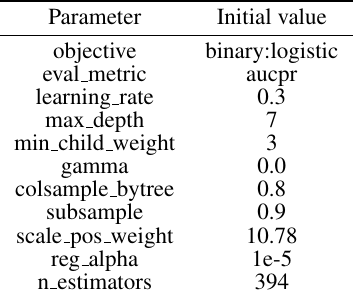
Table 2. Overview of tuning parameters with initial values Tweaking the parameters only results in small changes in the end result. However, two parameters are important for a suc- cessful change detection. The maximum depth of a decision tree should be at least seven, as otherwise the complexity of the model is too low to distinguish between temporary and permanent changes. Furthermore, it is very important that a higher weight is given to positive examples (i.e. changes) (with scale pos weight). Otherwise, the majority of polygons, which likely have no change, can influence the results (e.g. by classi- fying everything as not changed).